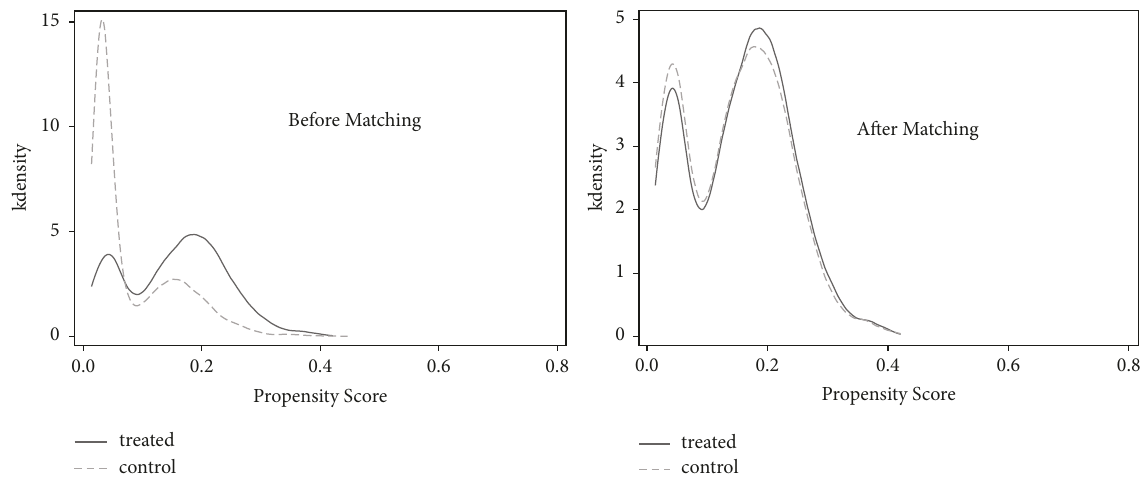
Figure 1: Kernel density plot with a comparison of the two groups (treated vs. control) before (left) and after (right) propensity score matching. Table 3: Regression results: the impact of experienced CEO succession on